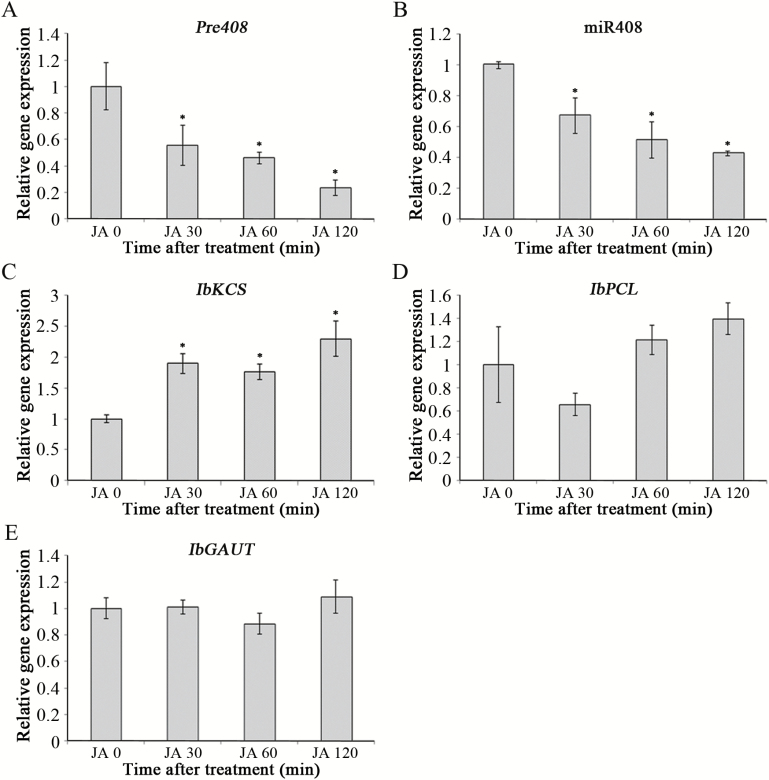
Expression patterns of pre408, miR408, and its targets after JA treatment. Total RNAs were extracted from sweet potato leaves sprayed with 50 µM MeJA for 0, 30, 60, and 120 min. The expression patterns of pre408 (A), miR408 (B), IbKCS (C), IbPCL (D), and IbGAUT (E) were determined by qRT-PCR. The expression of 5.8S rRNA was used as an internal control for normalization of miR408 expression. The expression of IbACT was used as an internal control for normalization of pre408 and its target genes. Data are indicated as means ±SD (n=4). The asterisks represent a significant difference by Student’s t-test (*P<0.05).